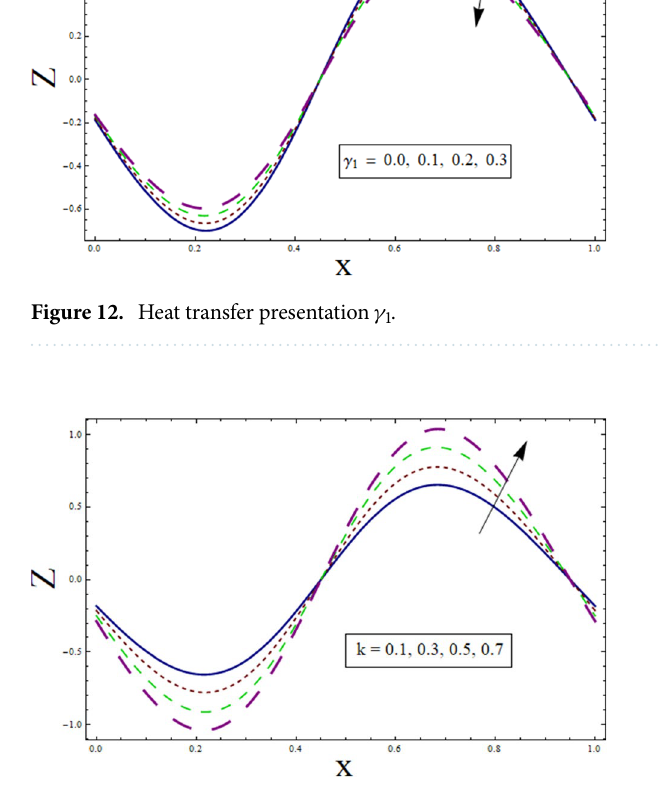
Figure 13. Heat transfer presentation k